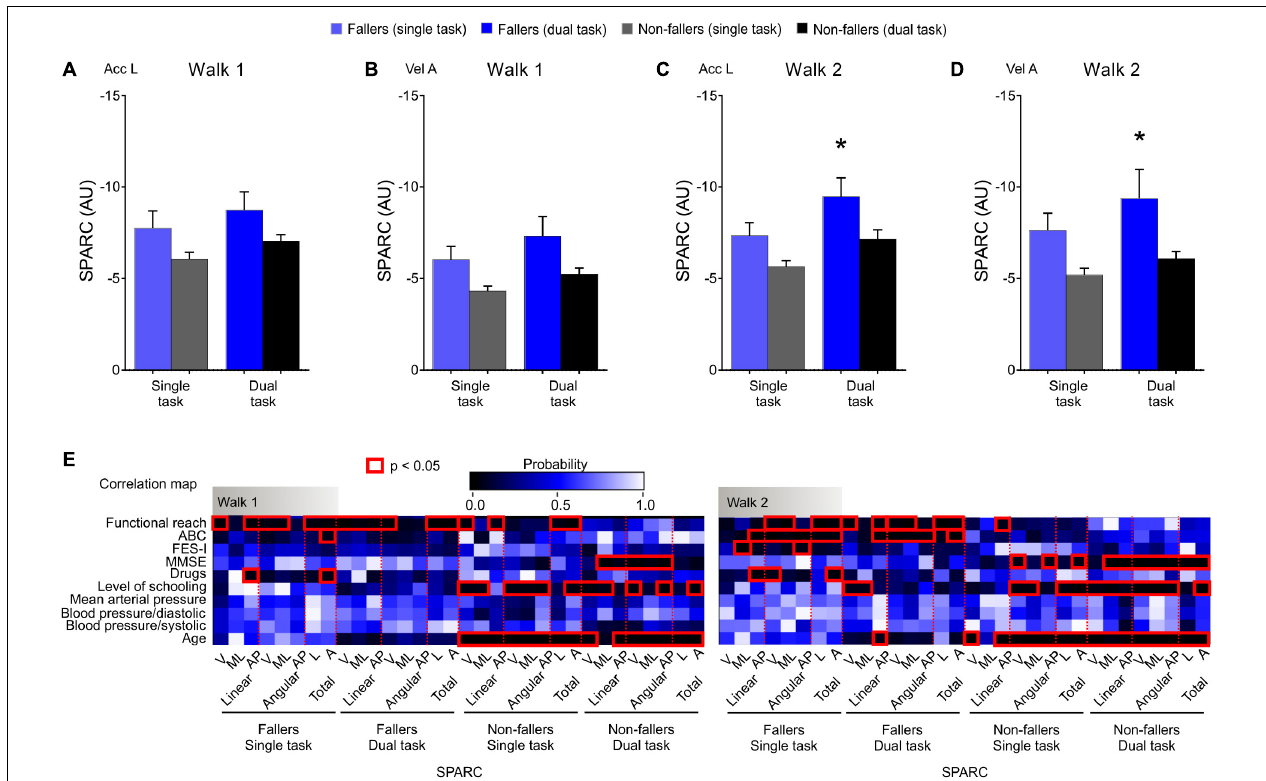
FIGURE 2 | Walking smoothness (SPARC) outcomes were stable across trials and reduced for fallers. (A–D) SPARC outcomes during walk 1 and 2 showed group and task, but not trial, main effects, thus we collapsed the three trials. Group and time effects were evident ( Table 3 ), alongside with post hoc effect for the dual task walk 2 phase. (E) The correlation map analysis showed a consistent correlation between functional reach, ABC scale, and movement smoothness in both the fallers and non-fallers. Correlations were also found with MMSE, level of schooling, and age for non-fallers. Two-way repeated-measures ANOVA with factors time (single X dual task) and group (fallers X non-fallers) followed by Sidak-correction ( post hoc ). Data are shown as mean ± SEM; n Fallers = 32; n Non − fallers = 32; * p < 0.05 ( post hoc ); red rectangles in E are * p < 0.05 (Spearman correlation). V: ventral; ML: mediolateral; AP: anteroposterior; SPARC: spectral arc length; Acc L: linear acceleration; Vel A: angular velocity; AU: adimensional unit; TUG: timed